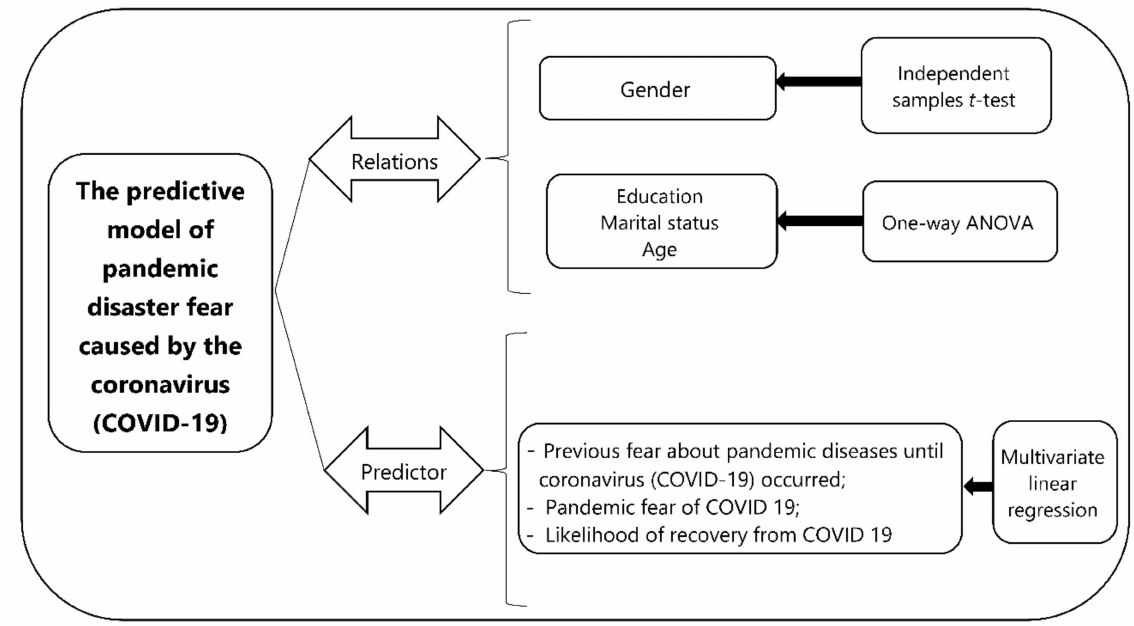
Figure 1. Research